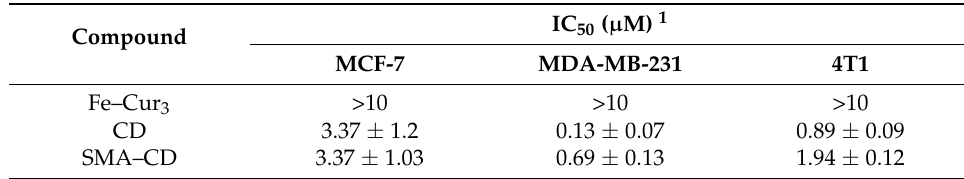
Table 2. The concentration sufficient to kill 50% of the cells (IC 50 ) values for CD and SMA–CD on hormone-responsive (MCF-7 cells) and hormone resistant (MDA-MB-231 and 4T1 cells) breast cancer cells.